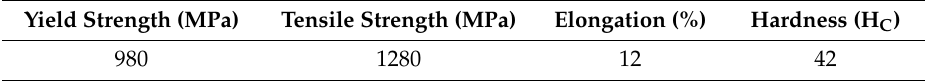
Table 3 . Mechanical properties of the Inconel 718.